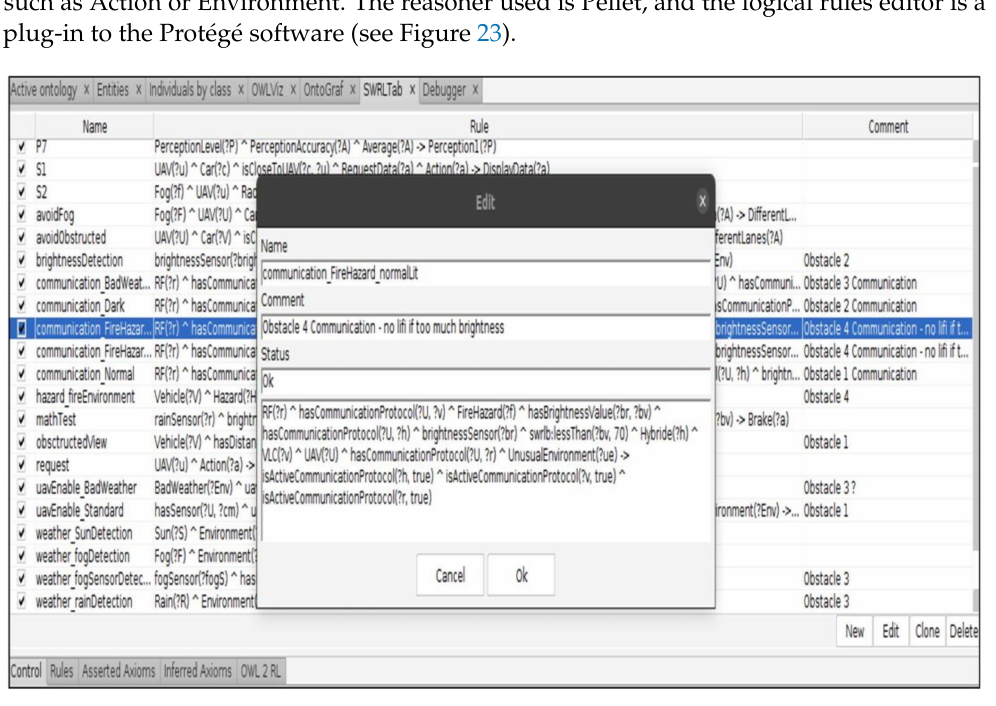
Figure 23. SWRL logical rules editor as it appears in the Prot é g é